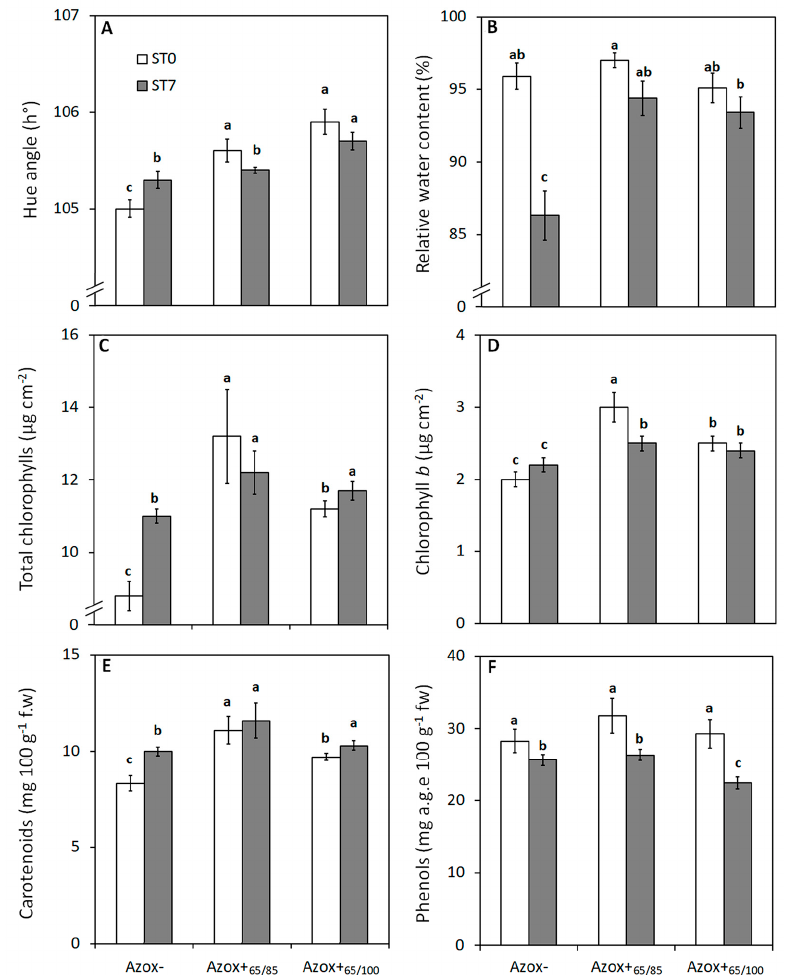
Figure 3. Effect of azoxystrobin application time on hue angle ( A ), relative water content ( B ), concentration of total chlorophylls ( C ), chlorophyll b ( D ), carotenoids ( E ), and phenols ( F ) in fresh and stored butterhead lettuce. Vertical bars (standard error) (n = 24) with different letters are significantly different according to the LSD test ( p = 0.05).